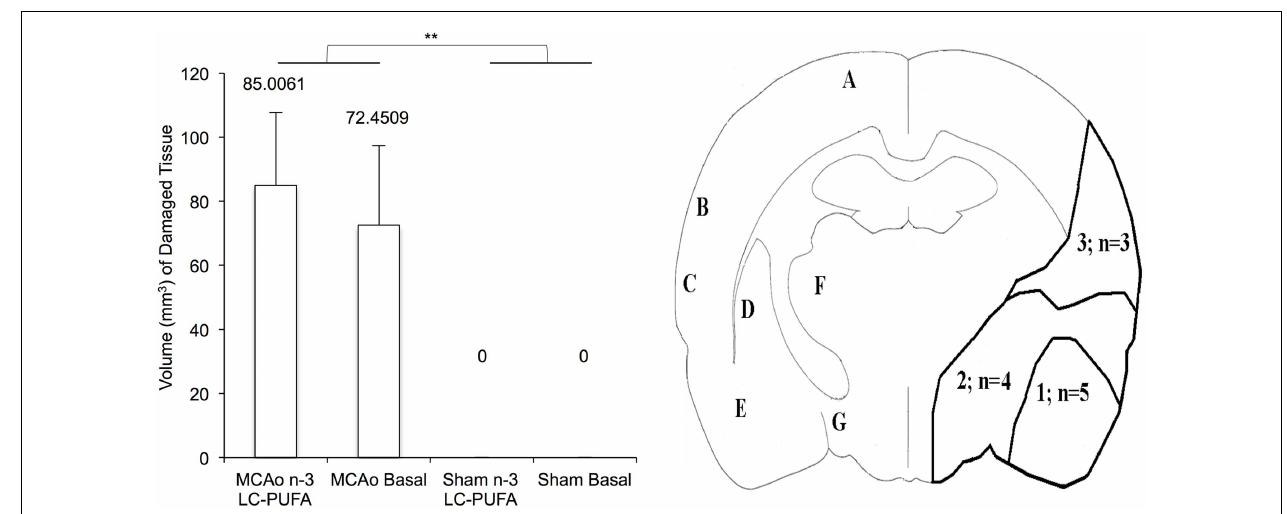
A in animals with larger infarcts; A, motor areas M1 and M2; B, somatosensory cortex; C, auditory cortex; D, caudate putamen; E, amygdala region; F, ventral posterolateral thalamic nucleus/ventral posteromedial thalamic nucleus; G, lateral hypothalamic area. *Denotes statistically significant at p = 0.05, **denotes statistically significant at p = 0.01. n = 11 n -3-LC-PUFA MCAo; n = 13 Basal MCAo; n = 12 n -3-LC-PUFA sham; n = 12 Basal